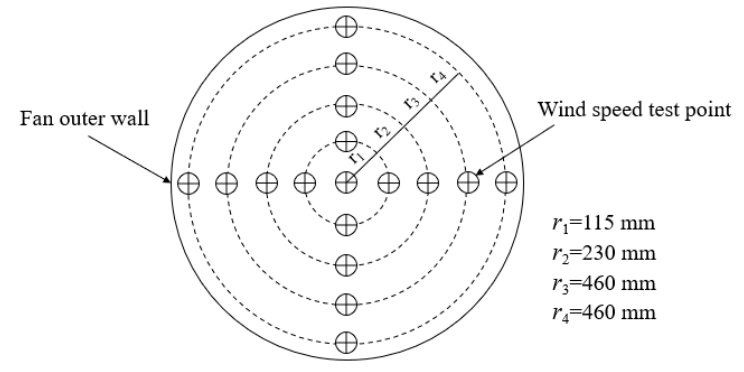
Figure 10. Schematic diagram of wind speed test points on fan outlet surface.